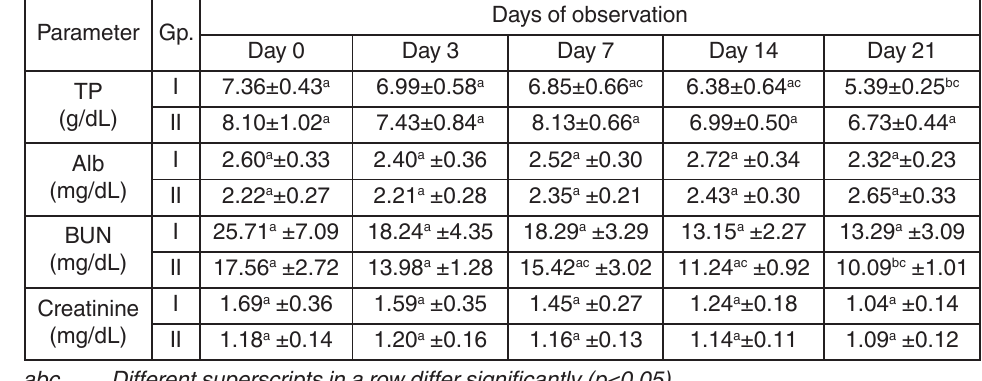
table 2 . Serum biochemical parameters on different days of observation in dogs affected with open and closed-cervix pyometra Parameter